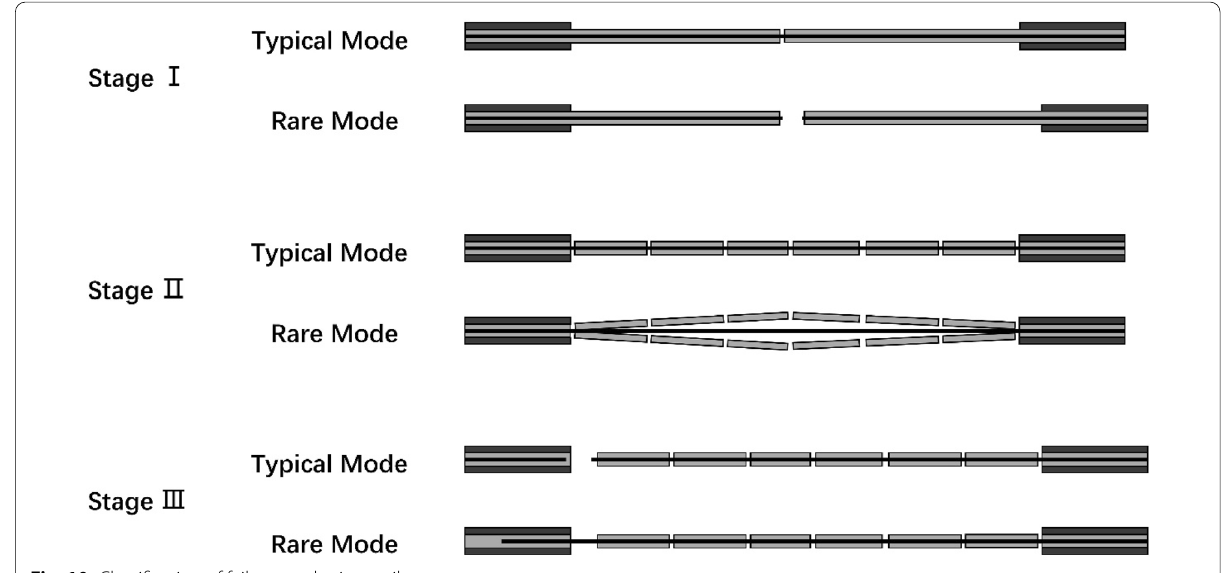
Fig. 10 Classification of failure modes in tensile